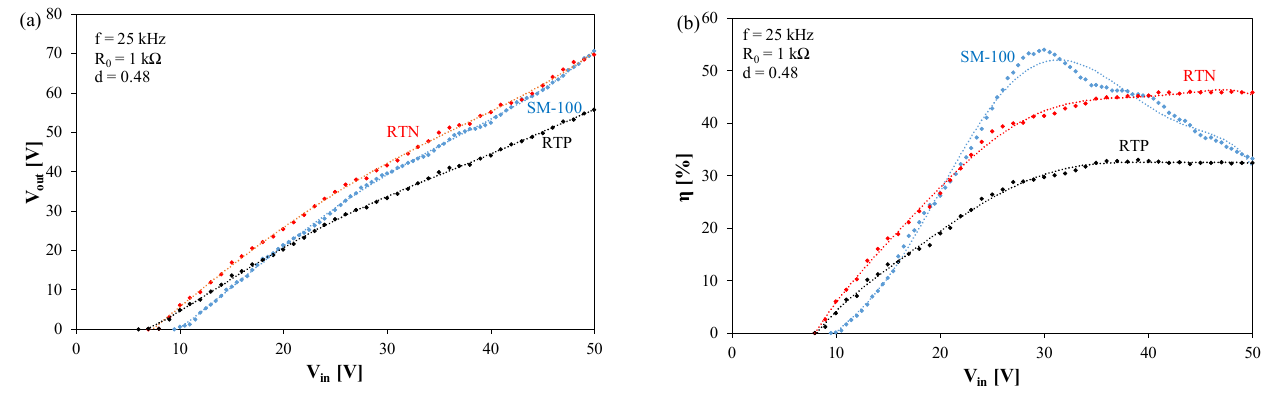
Figure 3. Measured dependences of the output voltage ( a ) and energy efficiency ( b ) of the tested DC-DC converter on its input voltage at R 0 = 1 k Ω .